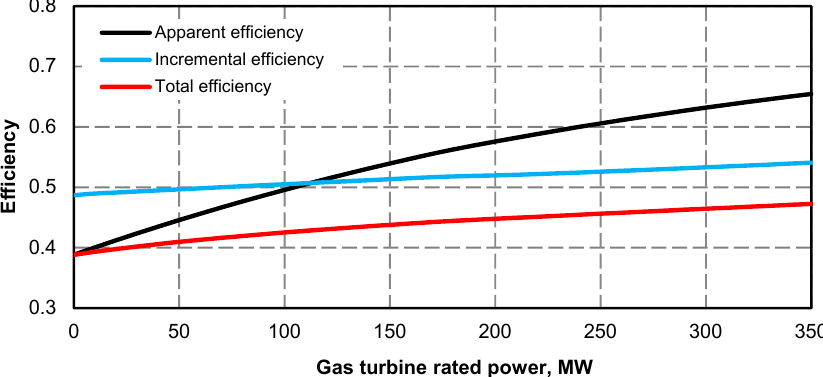
Figure 11. The energy efficiency for the power unit with superstructure added as a function of gas turbine rated power at a minimum steam boiler output of 133.3 kg / s and gas turbine operating at 60% of its rated power.